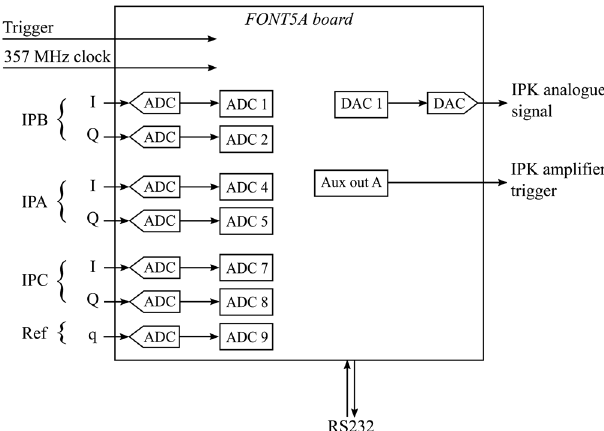
, and dip . Diagram adapted from ref